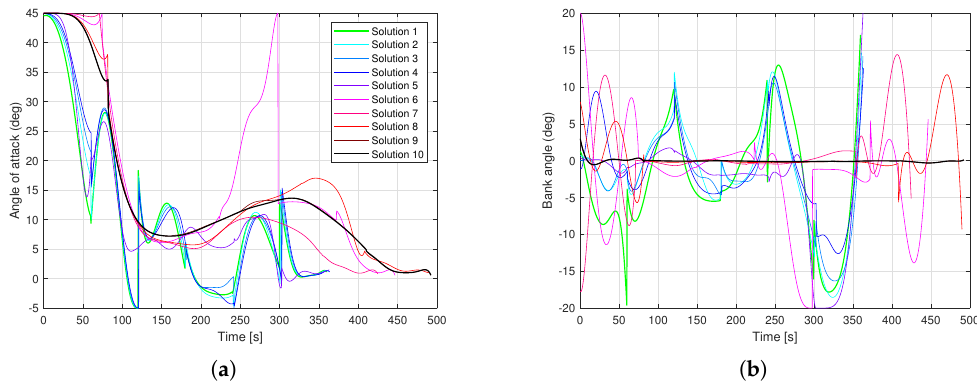
Figure 8. Control variables, which are consistent across all solutions in the Pareto-optimal set. ( a ) Angle of attack; ( b ) Bank